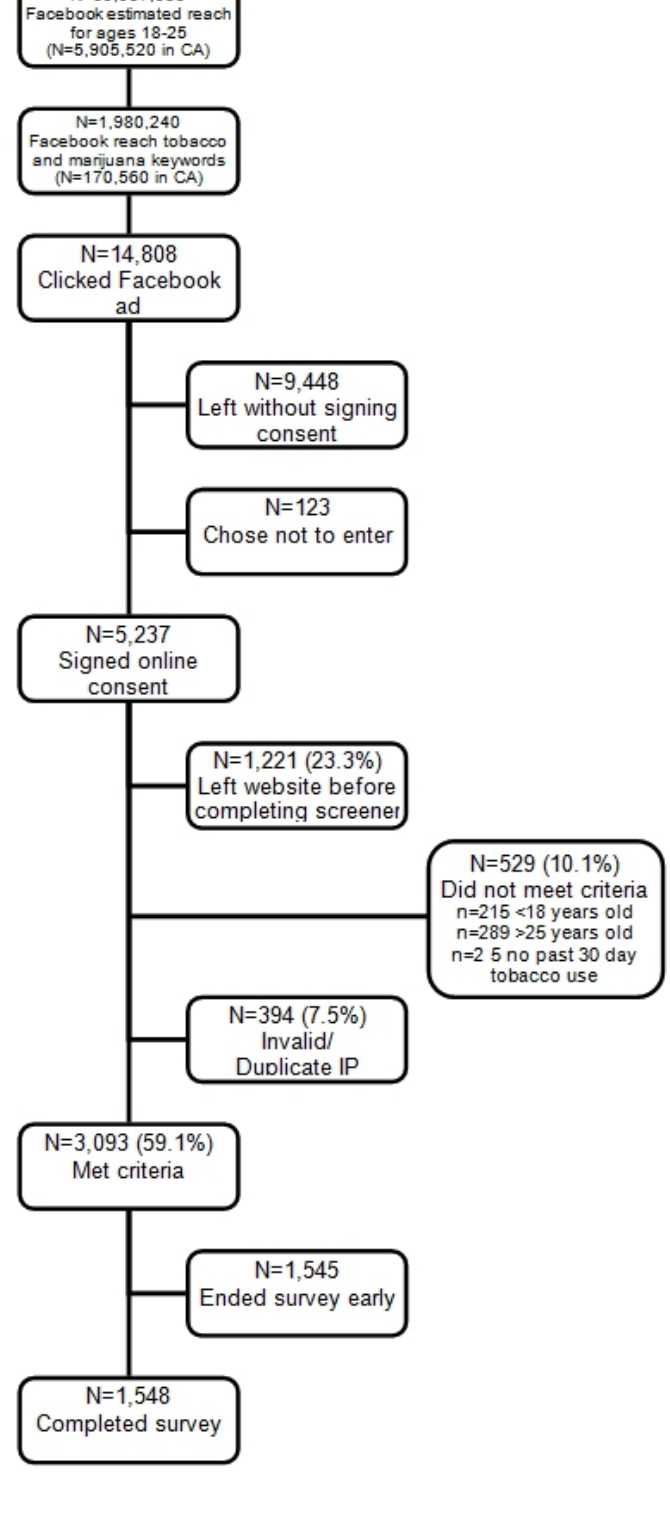
Figure 3. Facebook ad campaign reach and recruitment